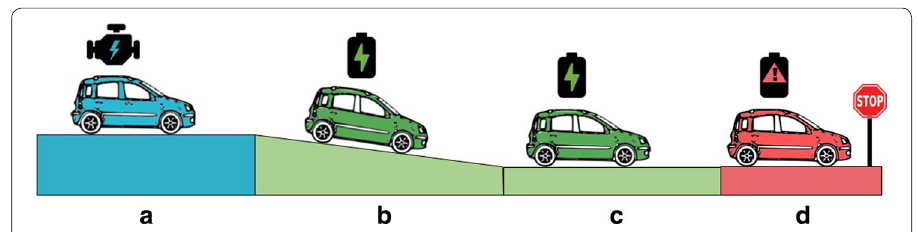
Fig. 2 Representation of the braking system behaviour: a electricity consumption, b recharging downhill, c recharging due to regenerative brake, d not recharging due to friction